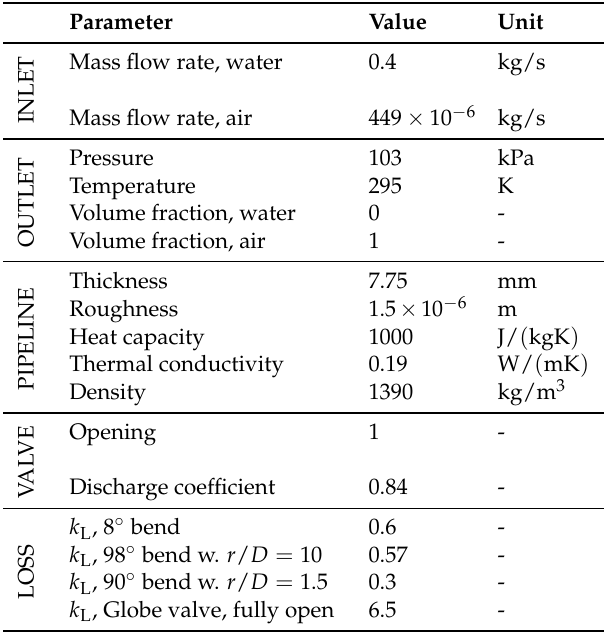
Table 3. Simulation model setup for